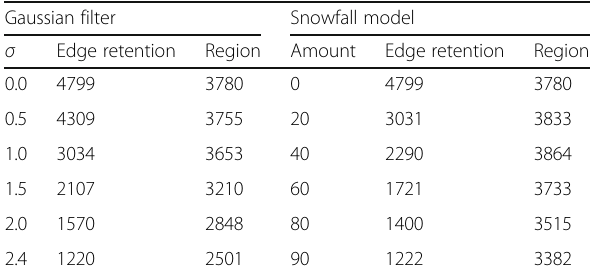
Table 1 The number of regions and edges in smoothing